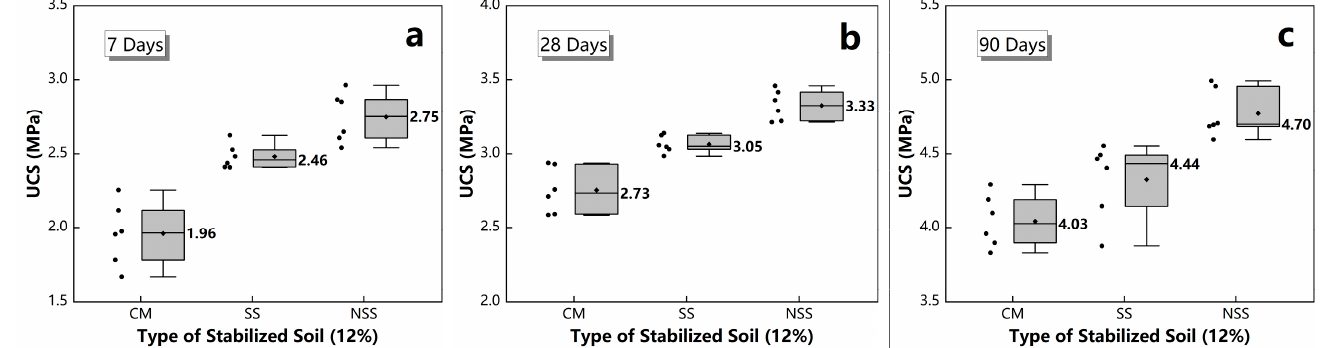
Figure 4. UCS of different stabilized soil under 12% dosage. ( a ) the UCS after 7 days curing; ( b ) the UCS after 28 days curing; ( c ) the UCS after 90 days curing.